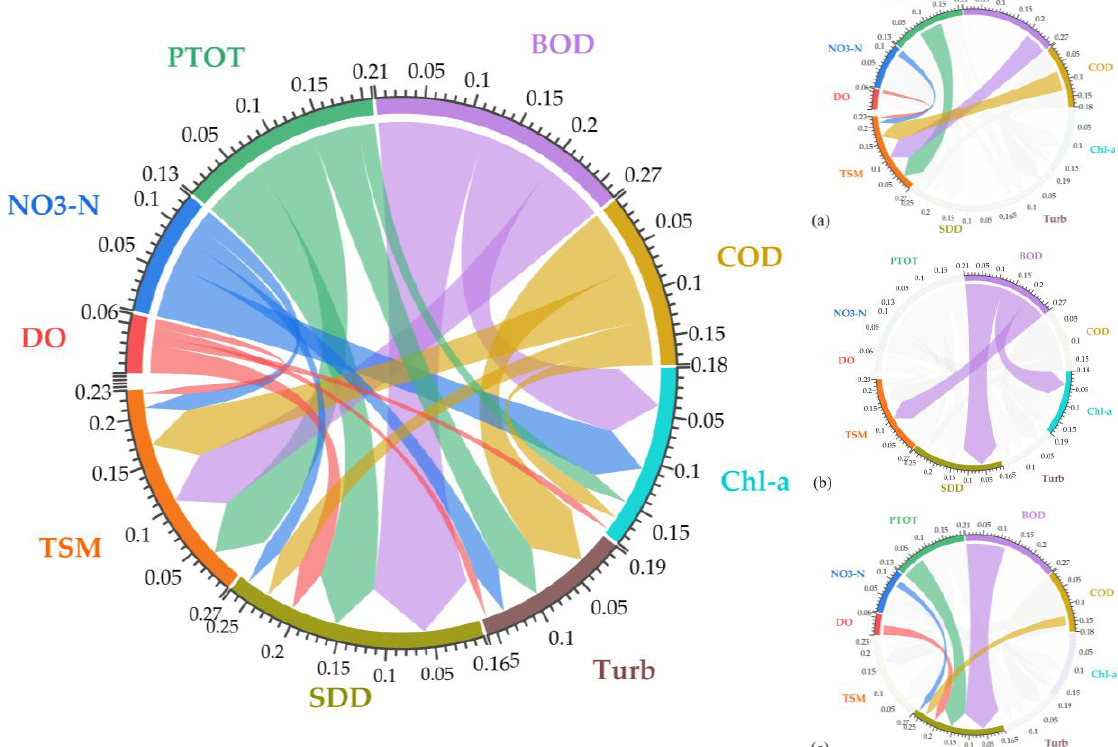
Figure 8. Sum and individual correlations of the OAC with nOAC. Diagrams of ( a ), ( b ) and ( c ) TSM, BOD and SDD, respectively.